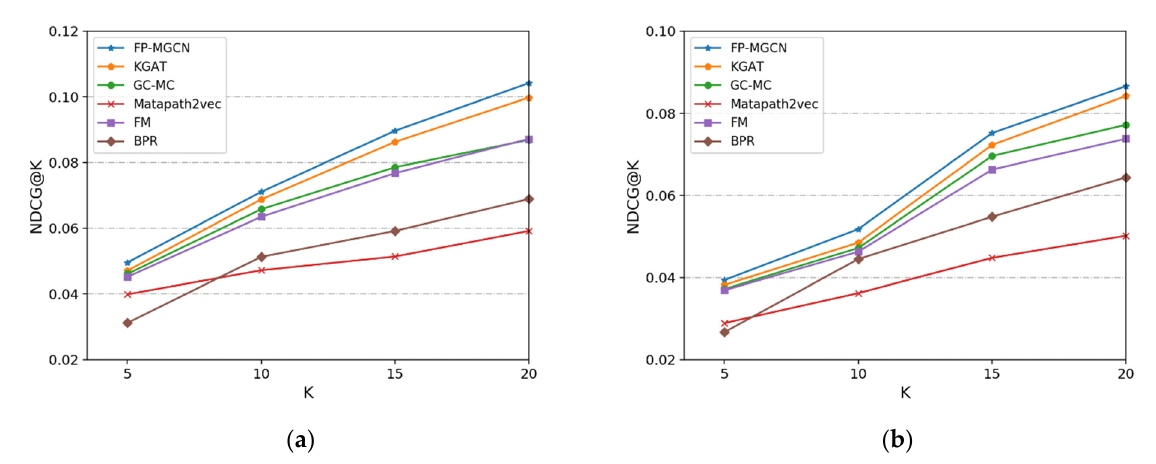
Figure 4. The results of NDCG@K on two datasets. ( a ) NDCG@K on Dianping; ( b ) NDCG@K on Yelp.